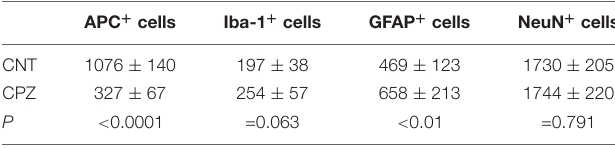
TABLE 2 | Differential vulnerabilities of brain cells to CPZ intoxication. APC + cells Iba-1 + cells GFAP +